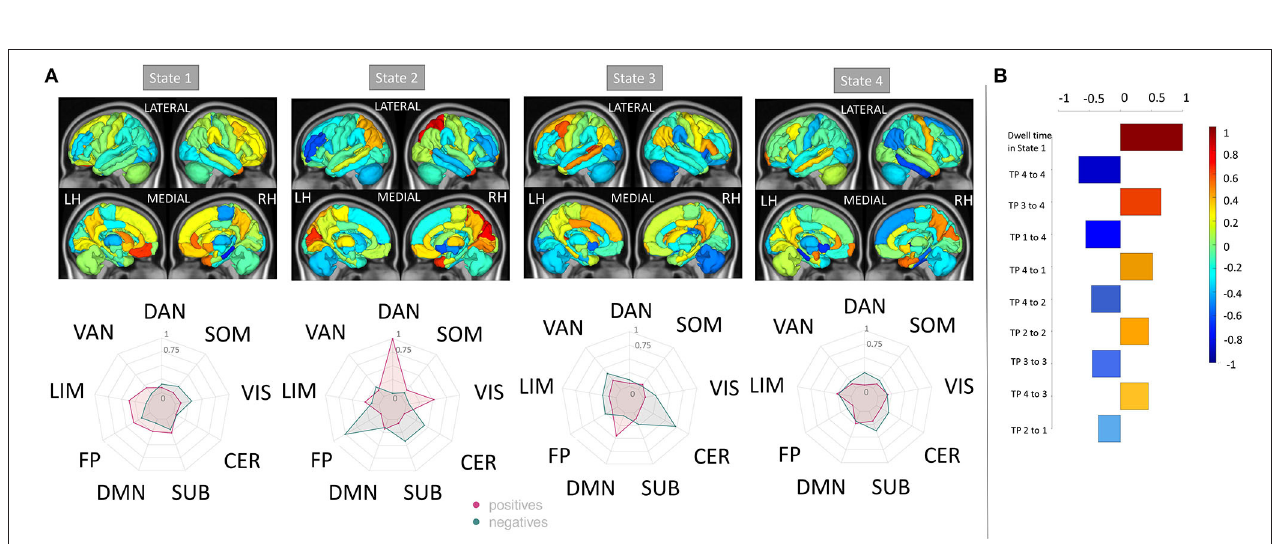
FIGURE 5 | Relative feature weights of the regional dFC model for the MS subgroup classification task. The relative feature weights (scaled by the feature weight with maximum magnitude) of the variables used in classifying pwMS by disability status using (A) regional dFC (node strength) and (B) dFC summary metrics (top 10 important features). The glass brain and radial plots in (A) show the relative feature weights from the regional dFC model and summarize the average of the regional dFC values over the Yeo functional networks (positive and negatives averaged separately). Negative values (cooler colors) indicate those connections where larger values were associated with greater probability of being in the HC group while positive values (hotter colors) indicate those connections where larger values were associated with greater probability of being in the pwMS group. DAN, dorsal attention; VAN, ventral attention; LIM, limbic; FP, fronto-parietal; DMN, default-mode network; SUB, subcortex; CER, cerebellum; VIS, visual; SOM, somato-motor.